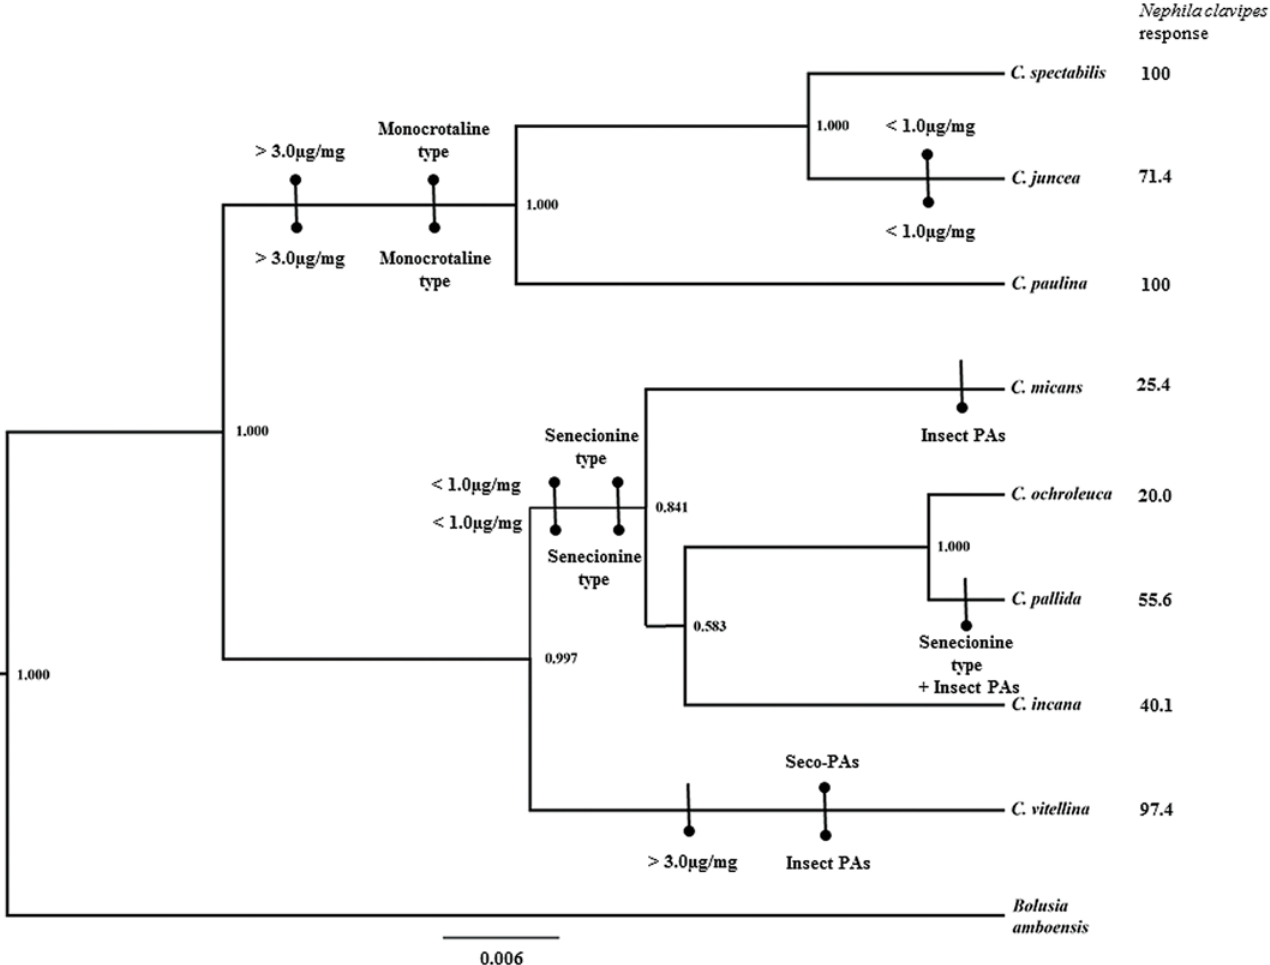
Fig 9. Bayesian inference topology for eight species of Crotalaria based on ITS sequences onto which are mapped the amount and type of PAs in leaves of the Crotalaria host plants (above) and in adults of Utetheisa ornatrix whose larvae fed on these plants (below). Response of the spider Nephila clavipes in relation to adults of Utethesia ornatrix is given beside each Crotalaria species. Numbers in each node indicate Bayesian posterior probabilities. The scale below the tree indicates the mean number of substitutions per